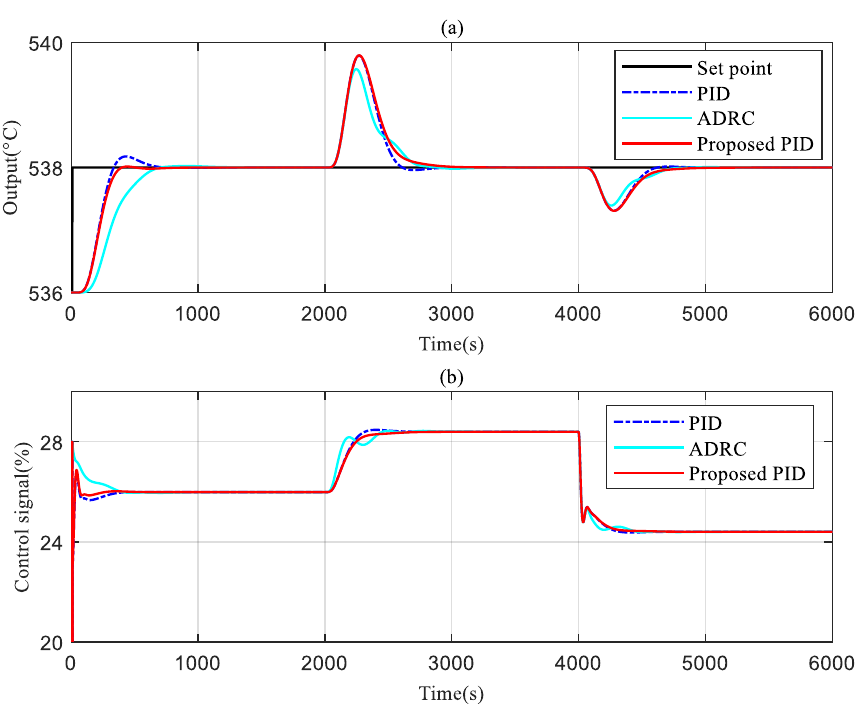
Figure 6. Control performance under an operating condition of 75% load ( a ): outputs, ( b ): control signals.